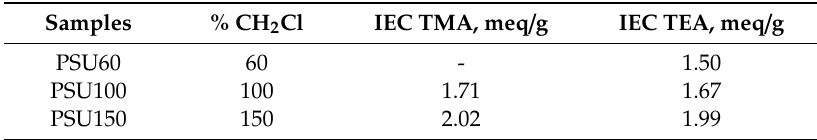
Table 3. IEC of quaternized PSU membranes.